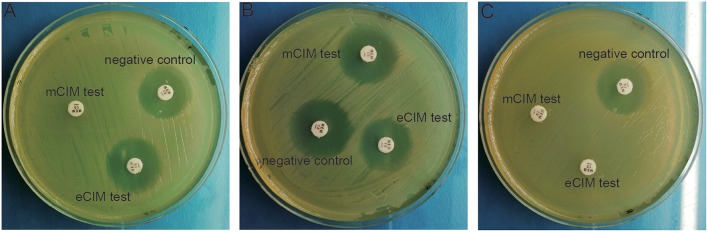
Phenotypic detection of carbapenemases in CRE bacteria. (A) mCIM positive and eCIM positive; (B) mCIM negative and eCIM negative; (C) mCIM positive and eCIM negative.